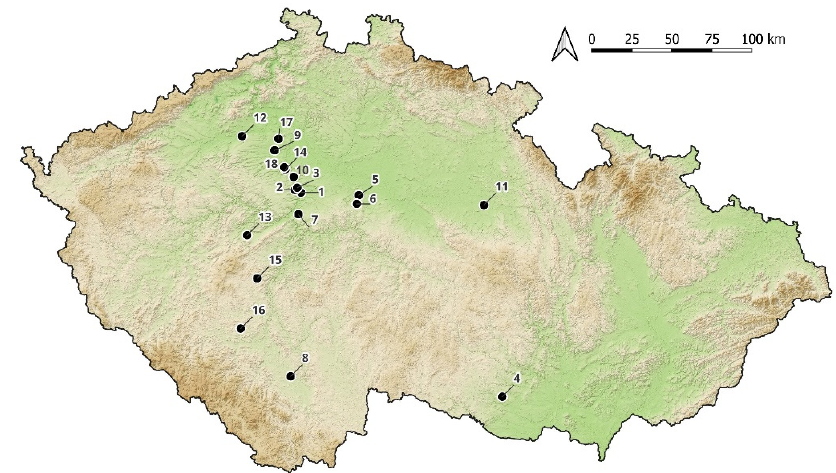
Figure 1. Map: 1. Prague, Nové m ě sto, 2. Prague, St ř ešovice, 3. Prague, Bubene č , 4. K ř epice hillfort, 5. Bylany, 6. Chotýš, 7. Lhota-Závist hillfort, 8. Mydlovary, 9. Č ernuc, 10. Roztoky-Žalov, 11. Plat ě nice, 12. Pátek, 13. Lochovice, 14. Holubice, 15. Rtišovice, 16. Láz, 17. Straškov-Vodochody, 18. Minice hillfort.